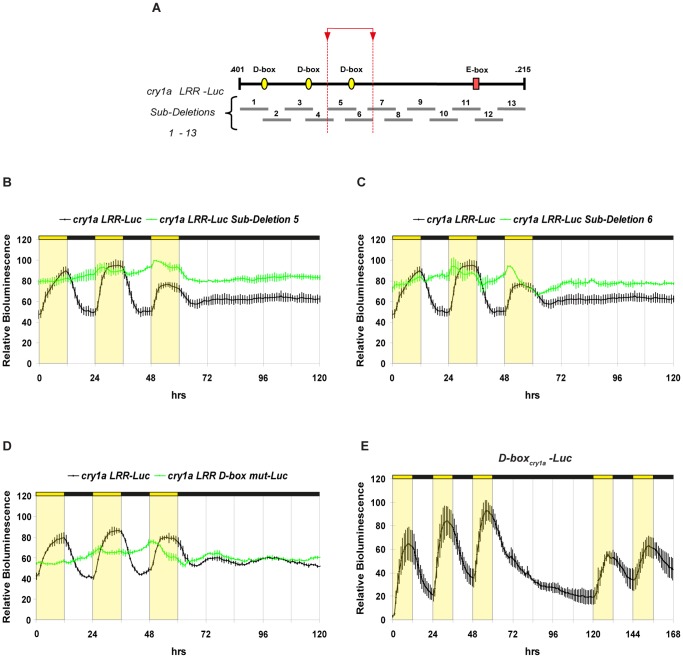
A single functional D-box is necessary and sufficient for the light response of the cry1a gene.(A) Schematic representation of cry1a LRR- Luc and sub-deletion constructs 1 to 13 (dark grey bars). The red rectangle denotes the putative E-box while the three yellow ellipses represent the putative D-boxes. The region delimited by cry1a LRR-Luc Sub-Deletions 5 and 6 is indicated by red arrowheads and red dotted lines. This region includes the light responsive D-box. (B–E) Representative real time bioluminescence assays from transfected PAC-2 cells. The identity of the transfected constructs and their colour codes are indicated above each panel. In each panel relative bioluminescence is plotted on the y-axis and time (hrs) on the x-axis. Each time-point represents the mean of at least four independently transfected wells +/− SD from a single experiment. Each experiment was performed a minimum of three times. Yellow and black bars above each panel represent the light and dark periods, respectively. Statistically significant differences are reported in Table S3.